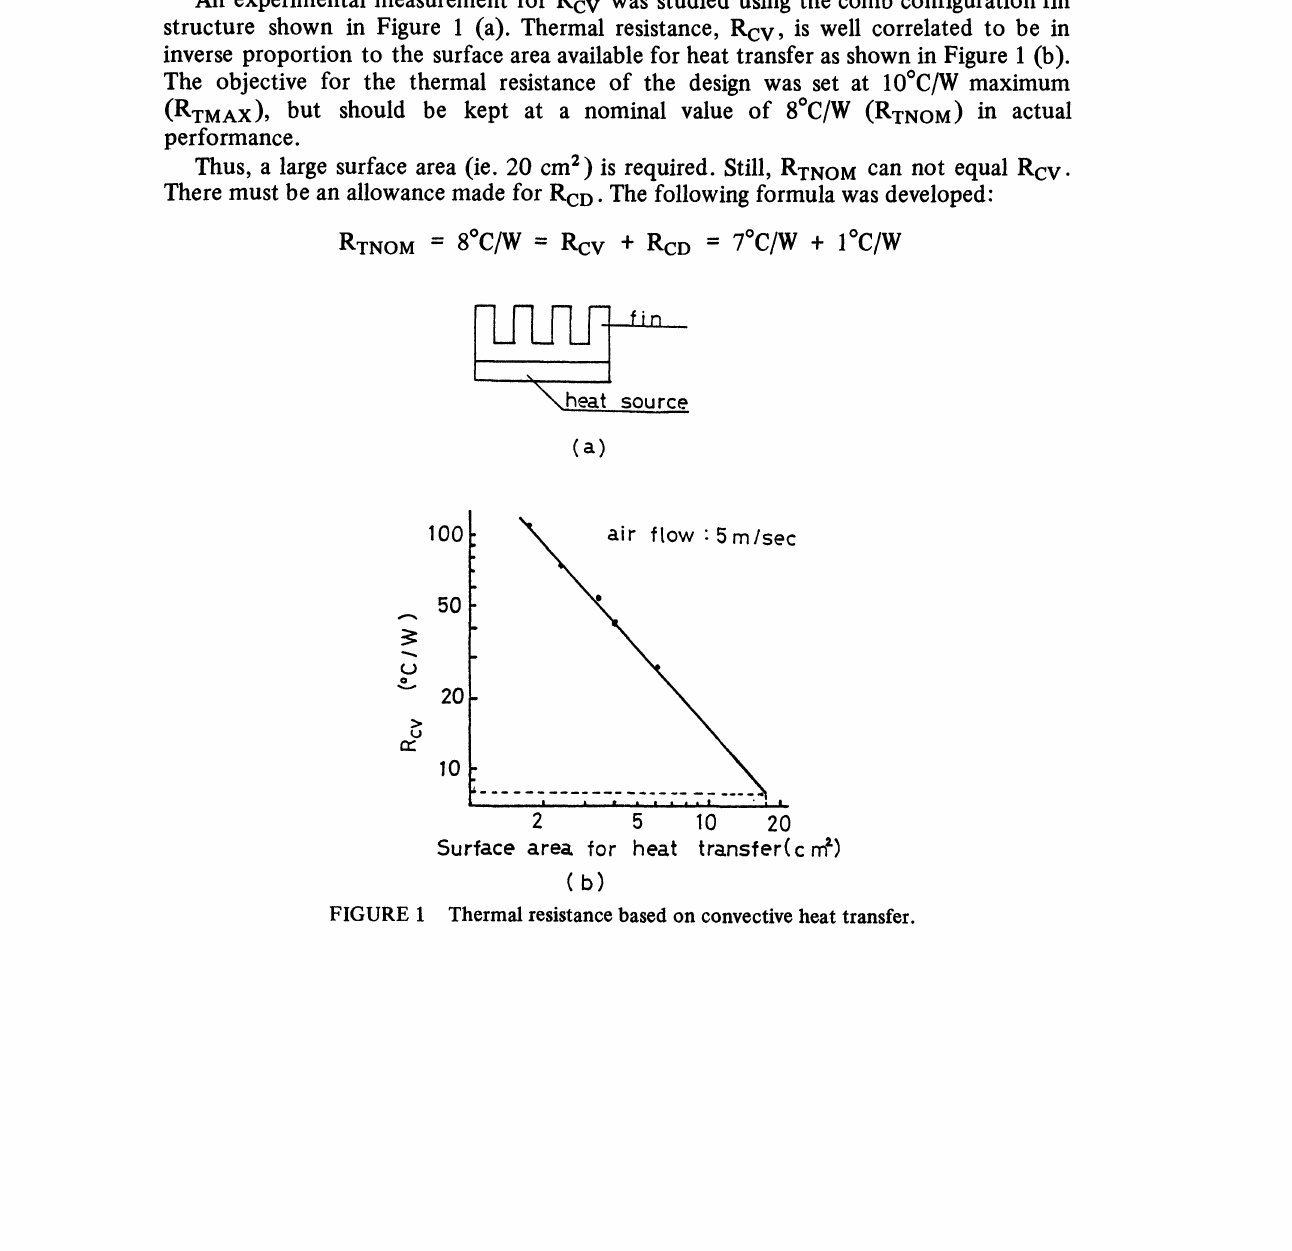
FIGURE Thermal resistance based on convective heat